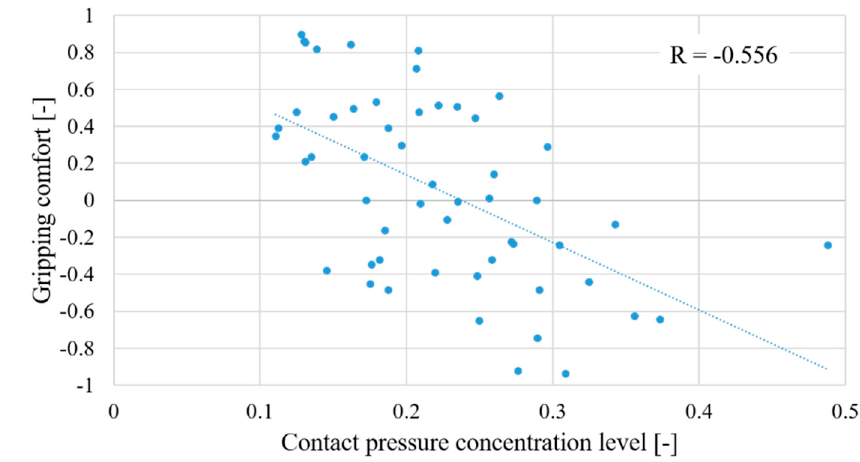
Figure 12. Relationship between the gripping comfort score and contact pressure concentration level.